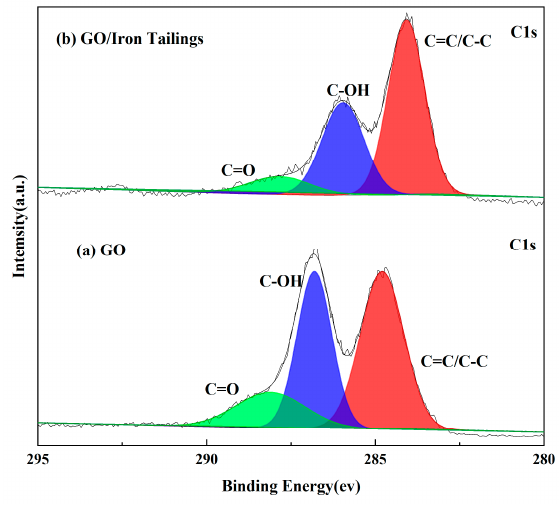
Figure 6. The high C1s deconvolution of GO ( a ) and GO/iron tailings ( b ).